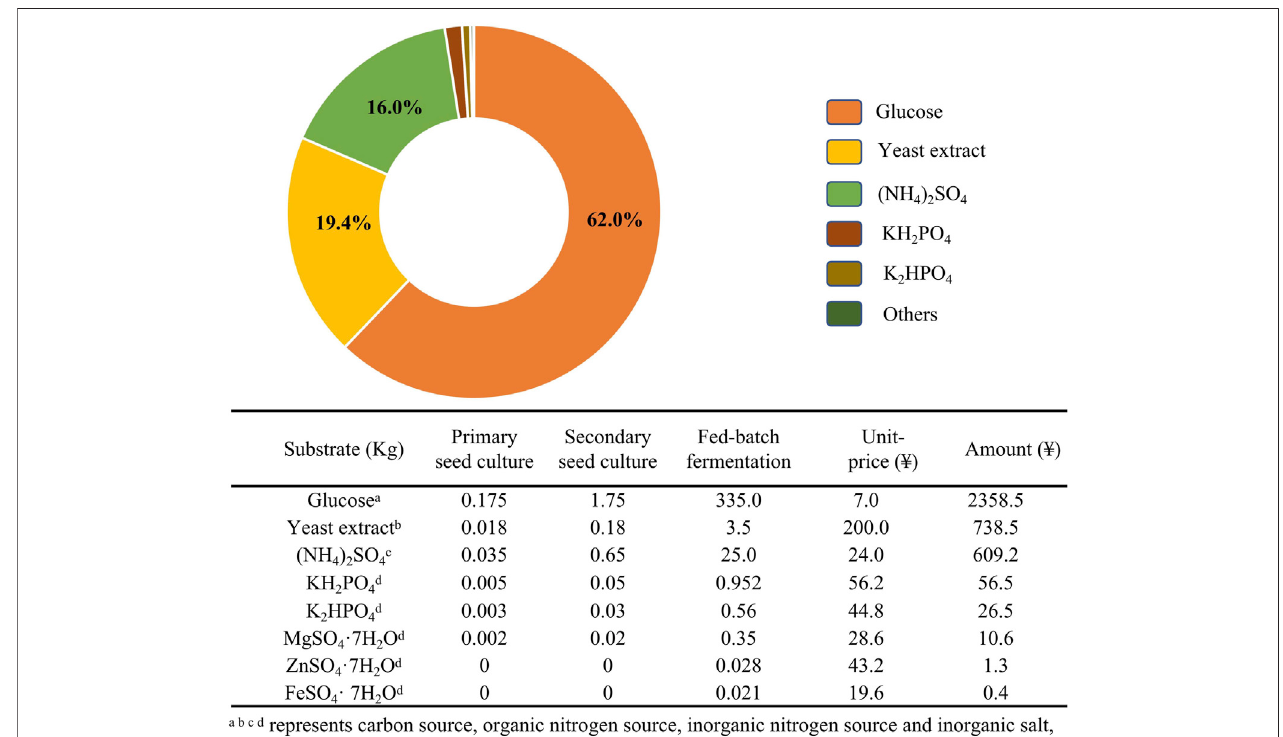
FIGURE 5 | Substrate costs for a Streptomyces sp. fermentation in a 1-t bioreactor with M3G medium.